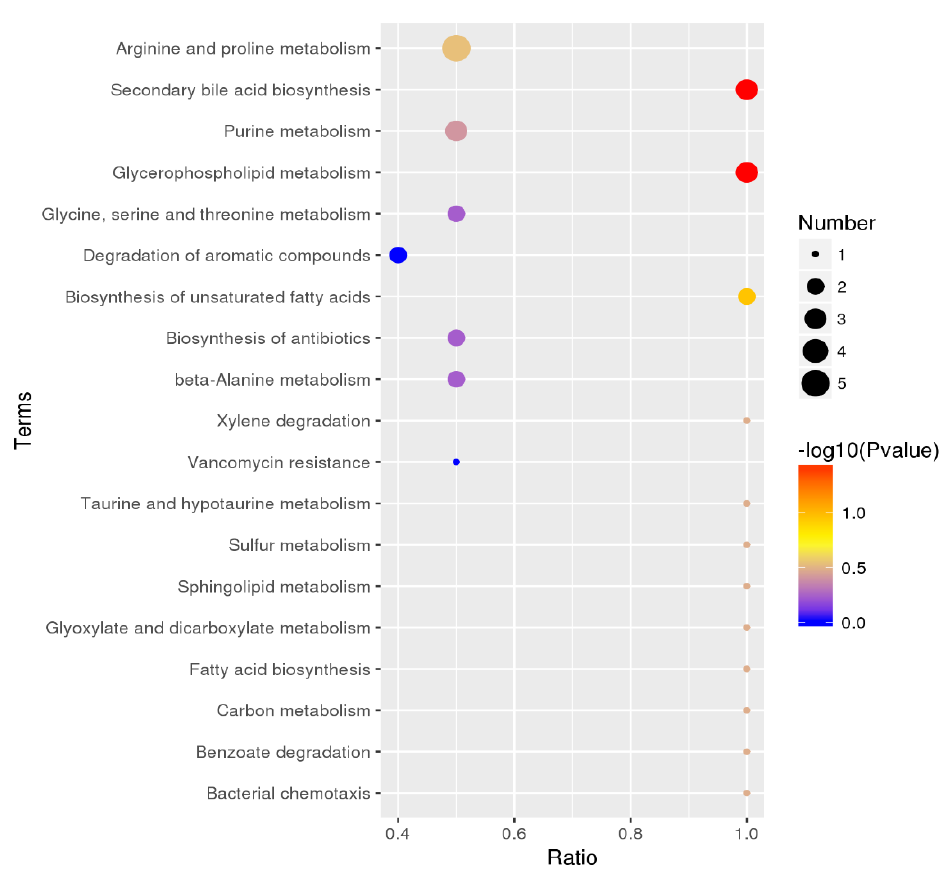
Figure 6. Bubble plot of Kyoto Encyclopedia of Genes and Genomes (KEGG) pathway enrichment for DEMs comparing B. velezensis mdj_36 and mdj-34 growth media. The rich factor is the ratio of the DEM number to the background number in an individual pathway. The rich factor value and degree of pathway enrichment are directly proportional. The dots' size represents the number of proteins, and the color of the dots represents the range of – log10 p -value, and a lower – log10 p -value indicates more significant pathway enrichment.